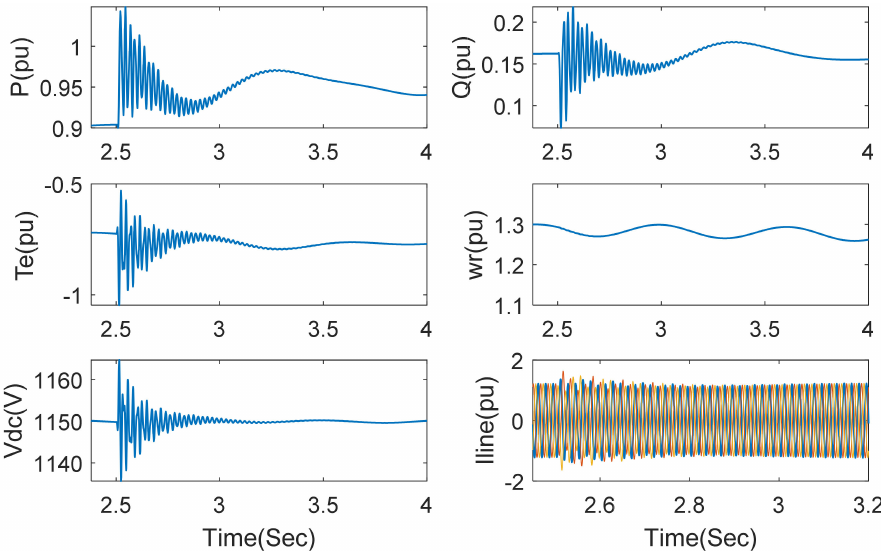
Figure 7. Transient responses under wind speed of 11 m/s and series-compensated level of 85%.